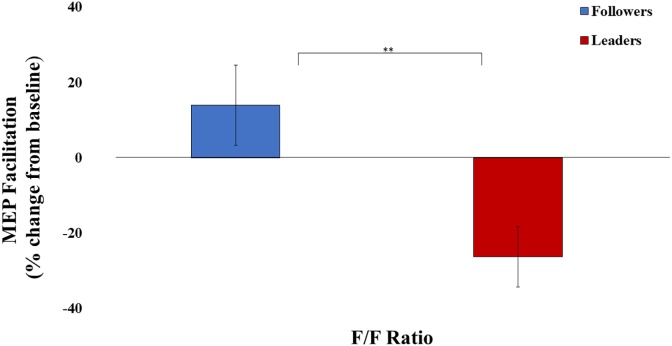
Motor-evoked potential (MEP) facilitation for both experimental conditions. ∗Significant at α = 0.05, ∗∗significant at α = 0.01, ∗∗∗significant at α = 0.001. Error bars indicate SEM.